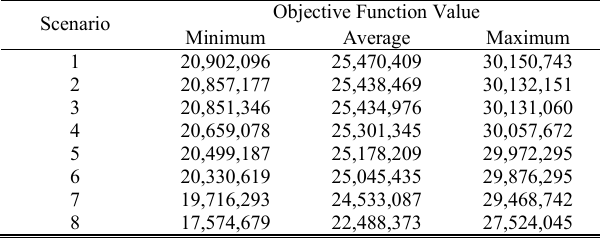
TABLE VIII O BJECTIVE F UNCTION V ARIATIONS – Y EAR